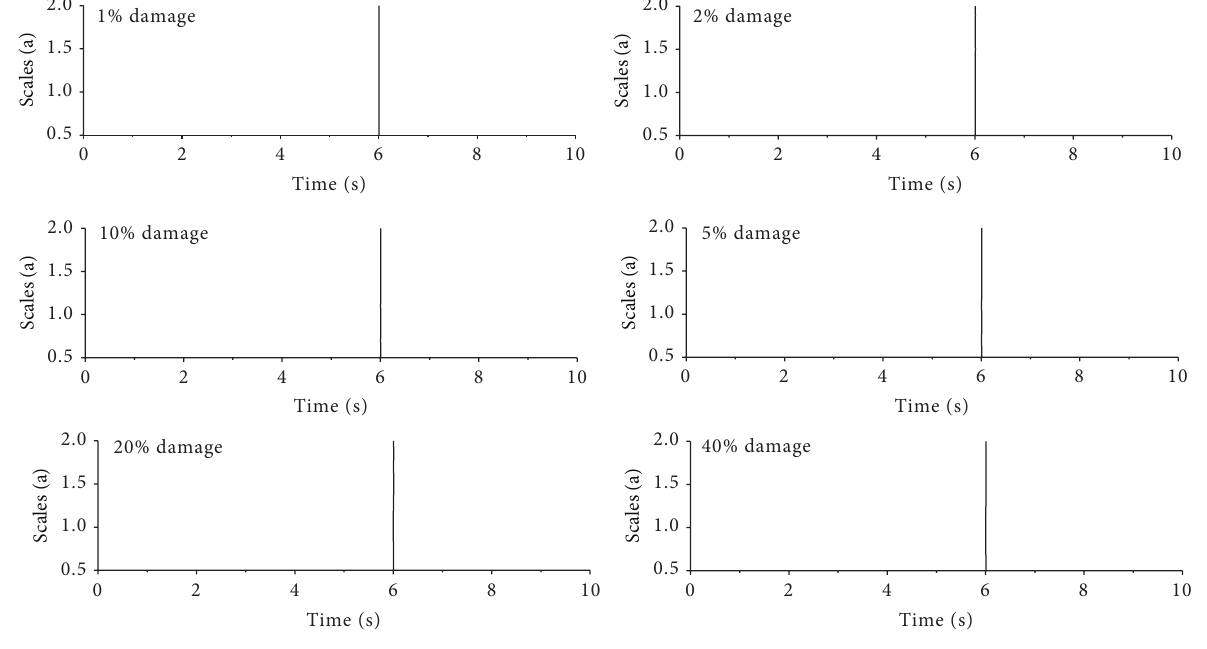
Figure 7: Modulus maxima line for various severities under seismic excitation. Table 1: Variations of Lipschitz exponent with damage severity without